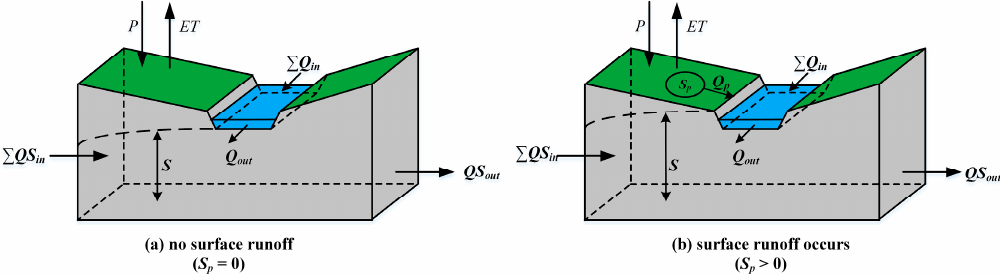
where T p is a time constant estimated by model calibration.